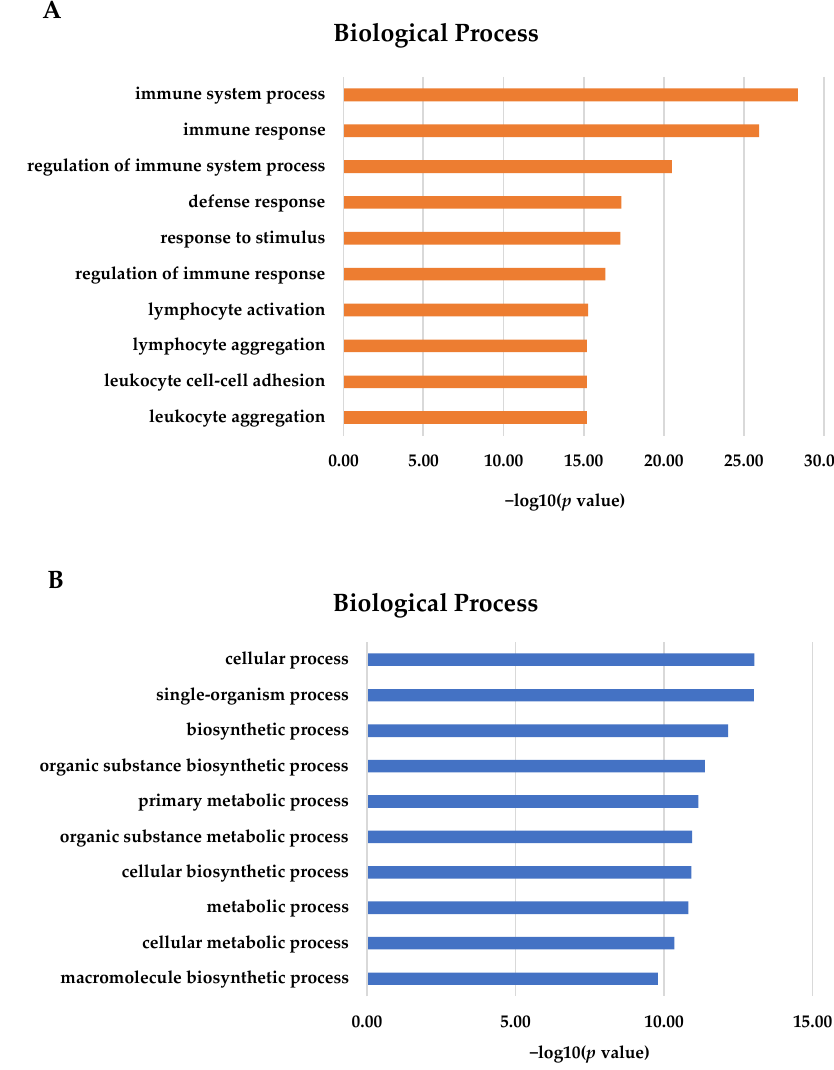
Figure 2. Gene Ontology (GO) terms for DEGs using KOBAS 3.0. ( A) The majority of DEGs in the gill tissues were associated with immune and defense response ( B ) Most DEGs in the adipose fin tissues were involved in the cellular process, biosynthesis, and metabolism.